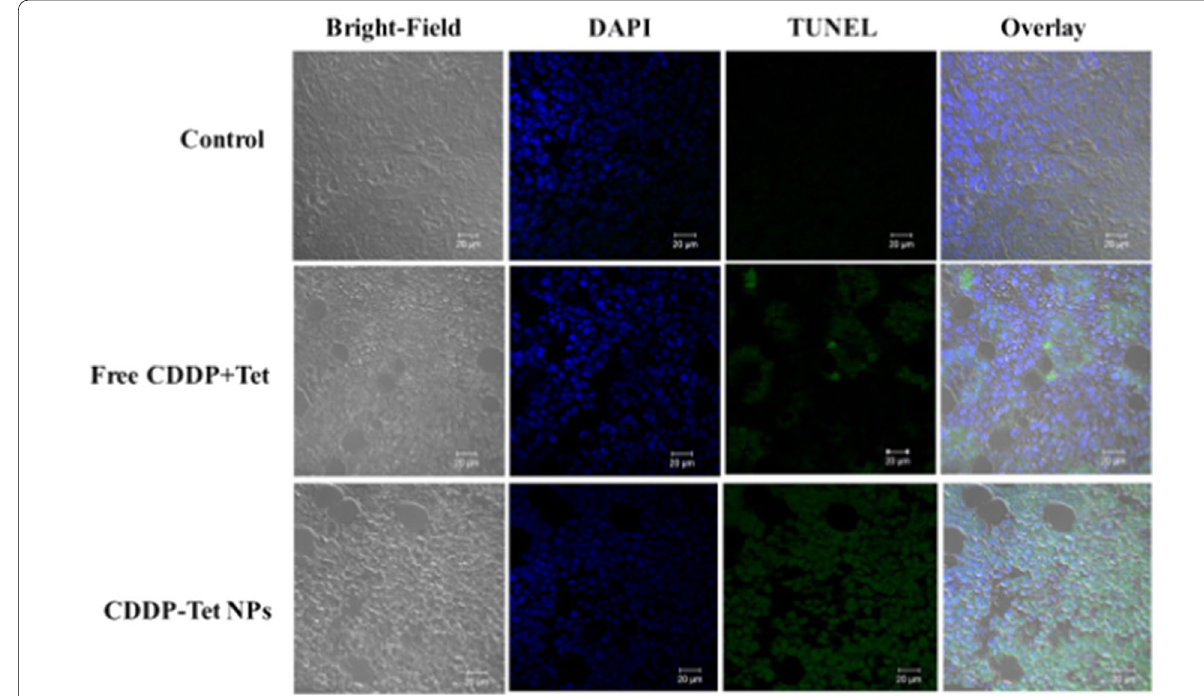
Fig. 7 Apoptotic cells were detected by a TUNEL assay (green) and co-stained by nuclear staining DAPI (blue)